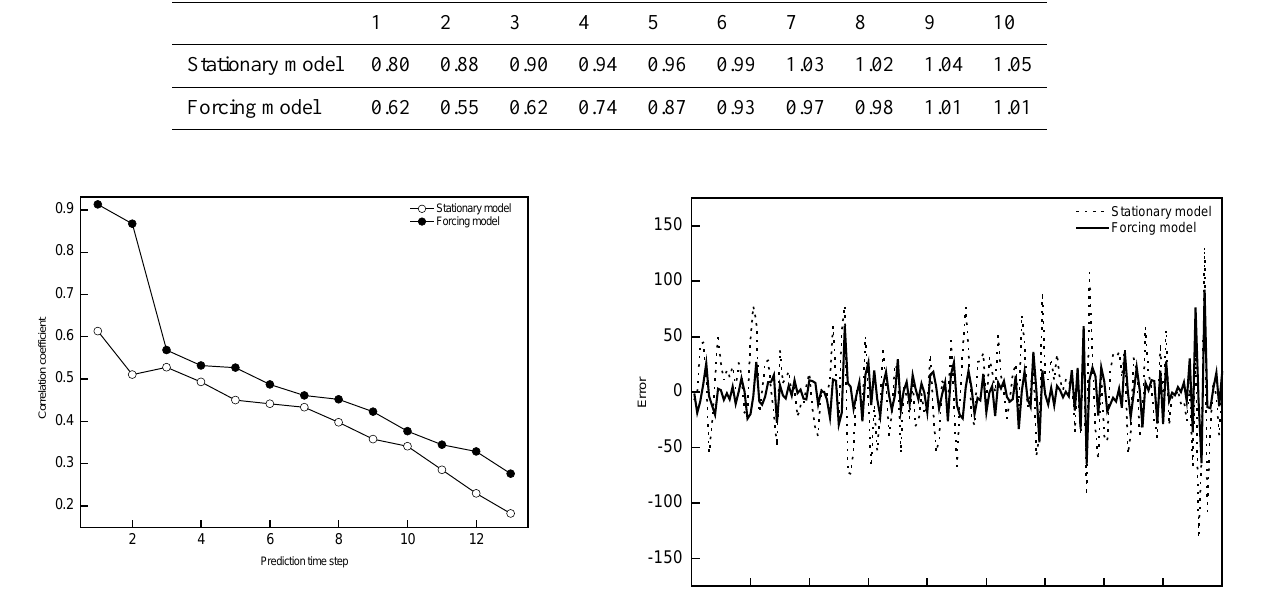
Figure 4. The comparison of prediction skills between models com- bined with or without driving force.